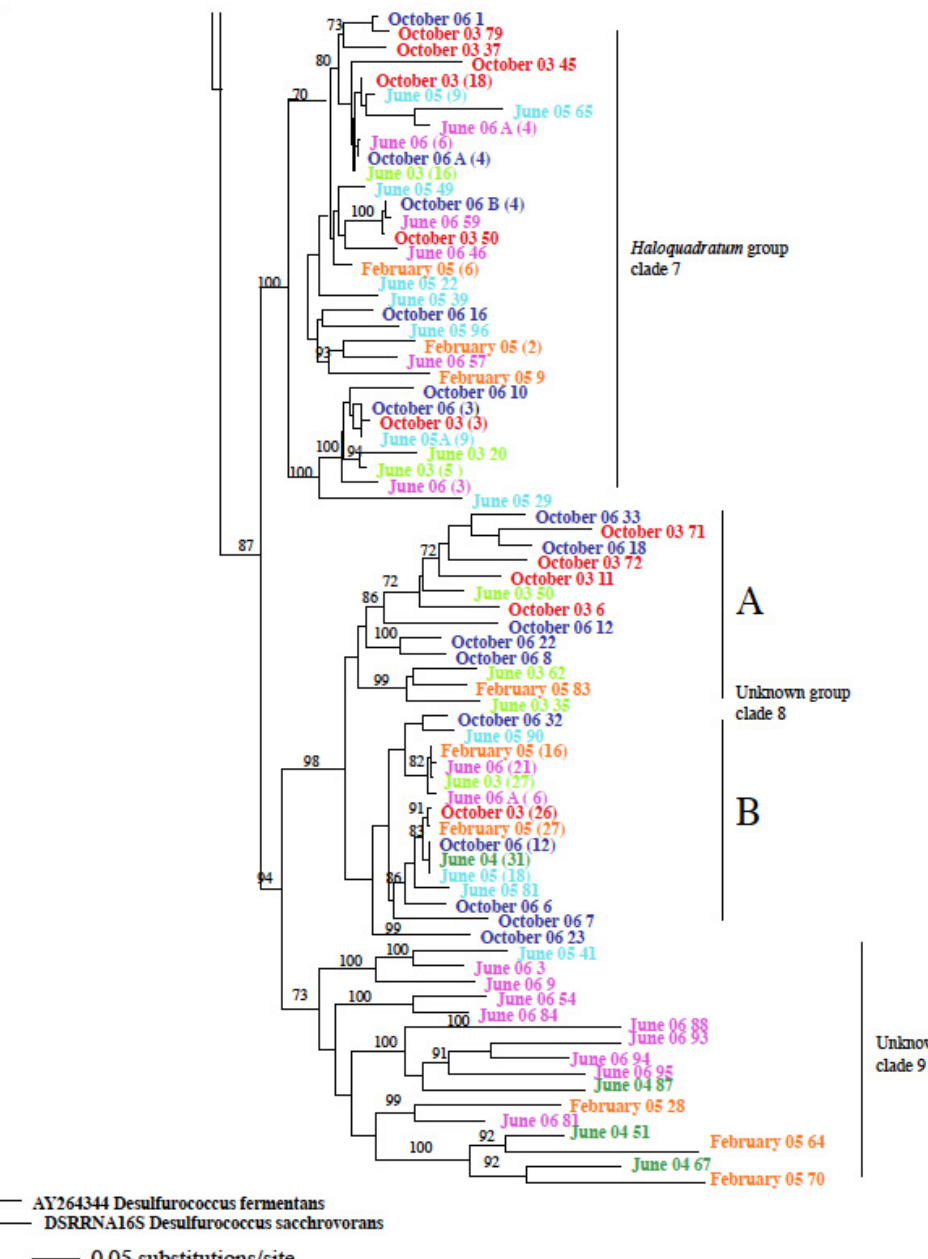
Figure 2. Phylogenetic tree constructed with all of the archaeal sequences retrieved from 16S rRNA gene clone libraries from north arm of Great Salt Lake. Numbers in parentheses indicate the number of sequences in the contig. The known genera from the database were clustered together forming two subclusters. Halorhabdus , Halosimplex , Halomicrobium , Haloarcula , Halobiforma and Haloplanus were all phylogenetically related forming one subcluster while Haloferax , Halosarcina , Halobacterium , Natronomonas , and Halorubrum formed another sub-cluster. One species of Halorubrum ( Hrr. lacusprofundi ) formed the remaining